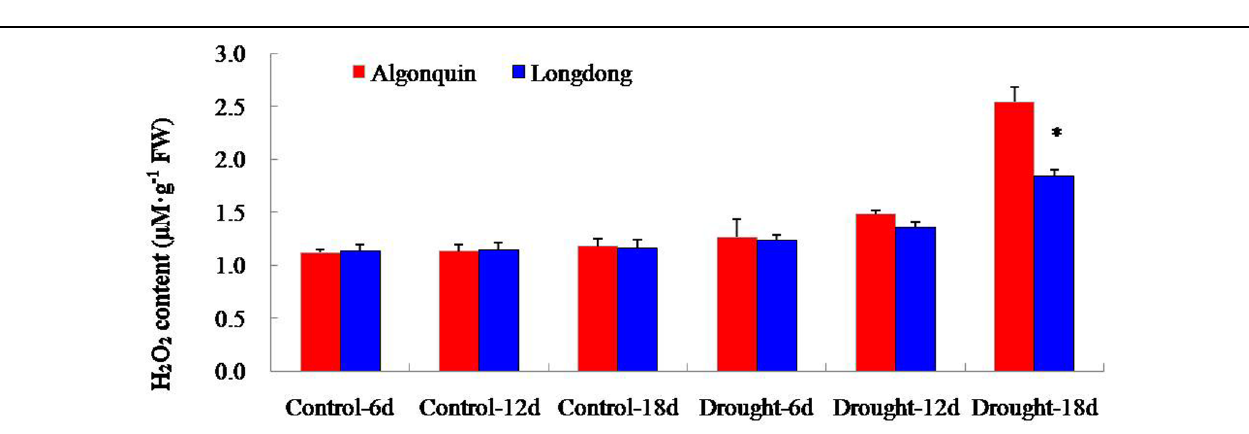
et al., 2012a). Stomatal conductance regulates